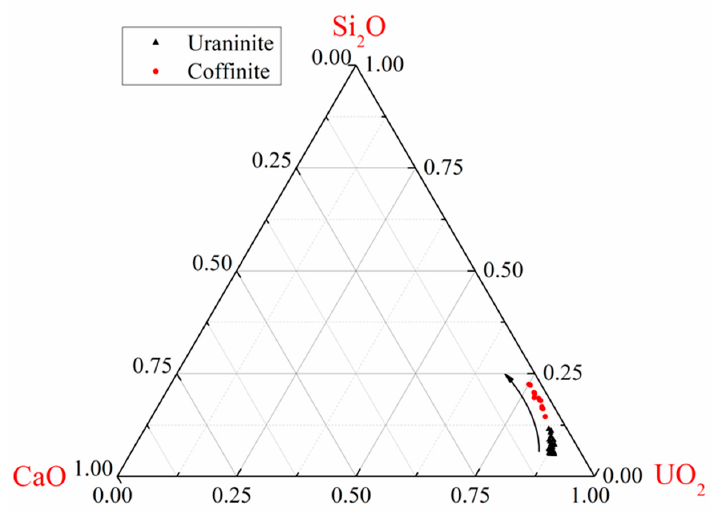
Figure 11. The significant trends indicated an overall U, Ca loss, and Si gain during metasomatism.